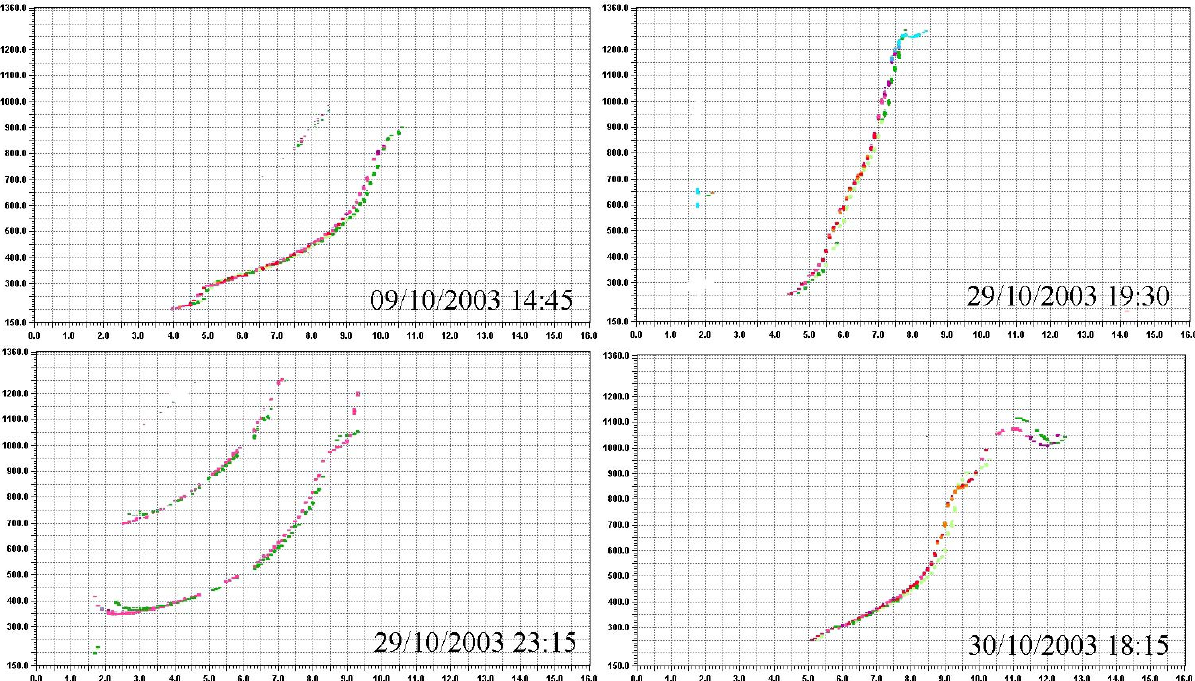
Fig. 7. Examples of ionograms when the F3 layer appeared at Jicamarca on geomagnetic quiet day 9 and disturbed days 29 and 30 October